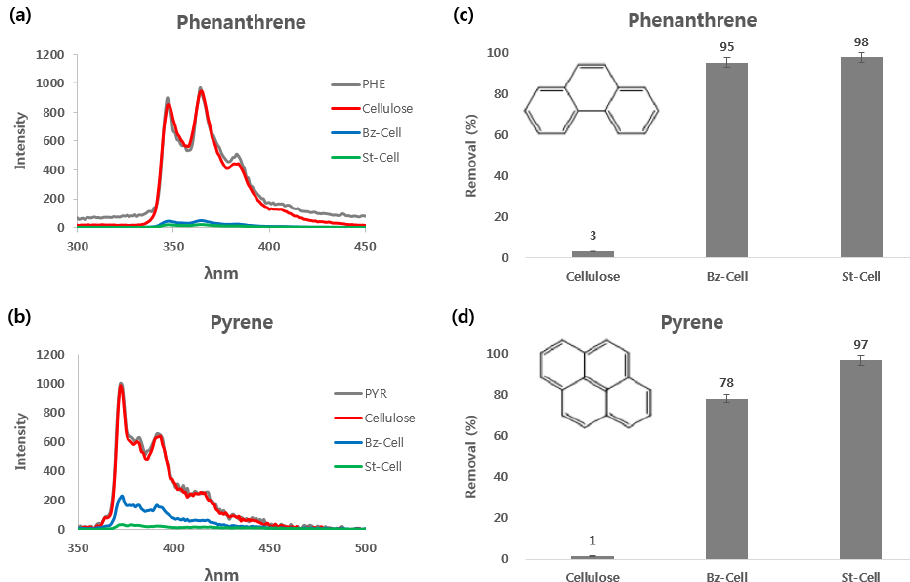
Figure 7. Emission spectra of phenanthrene ( a ) and pyrene ( b ). Removal efficiency (%) of phenanthrene ( c ) and pyrene ( d ), as compared with cellulose. The insets in ( c ) and ( d ) show the chemical structure of phenanthrene and pyrene, respectively.